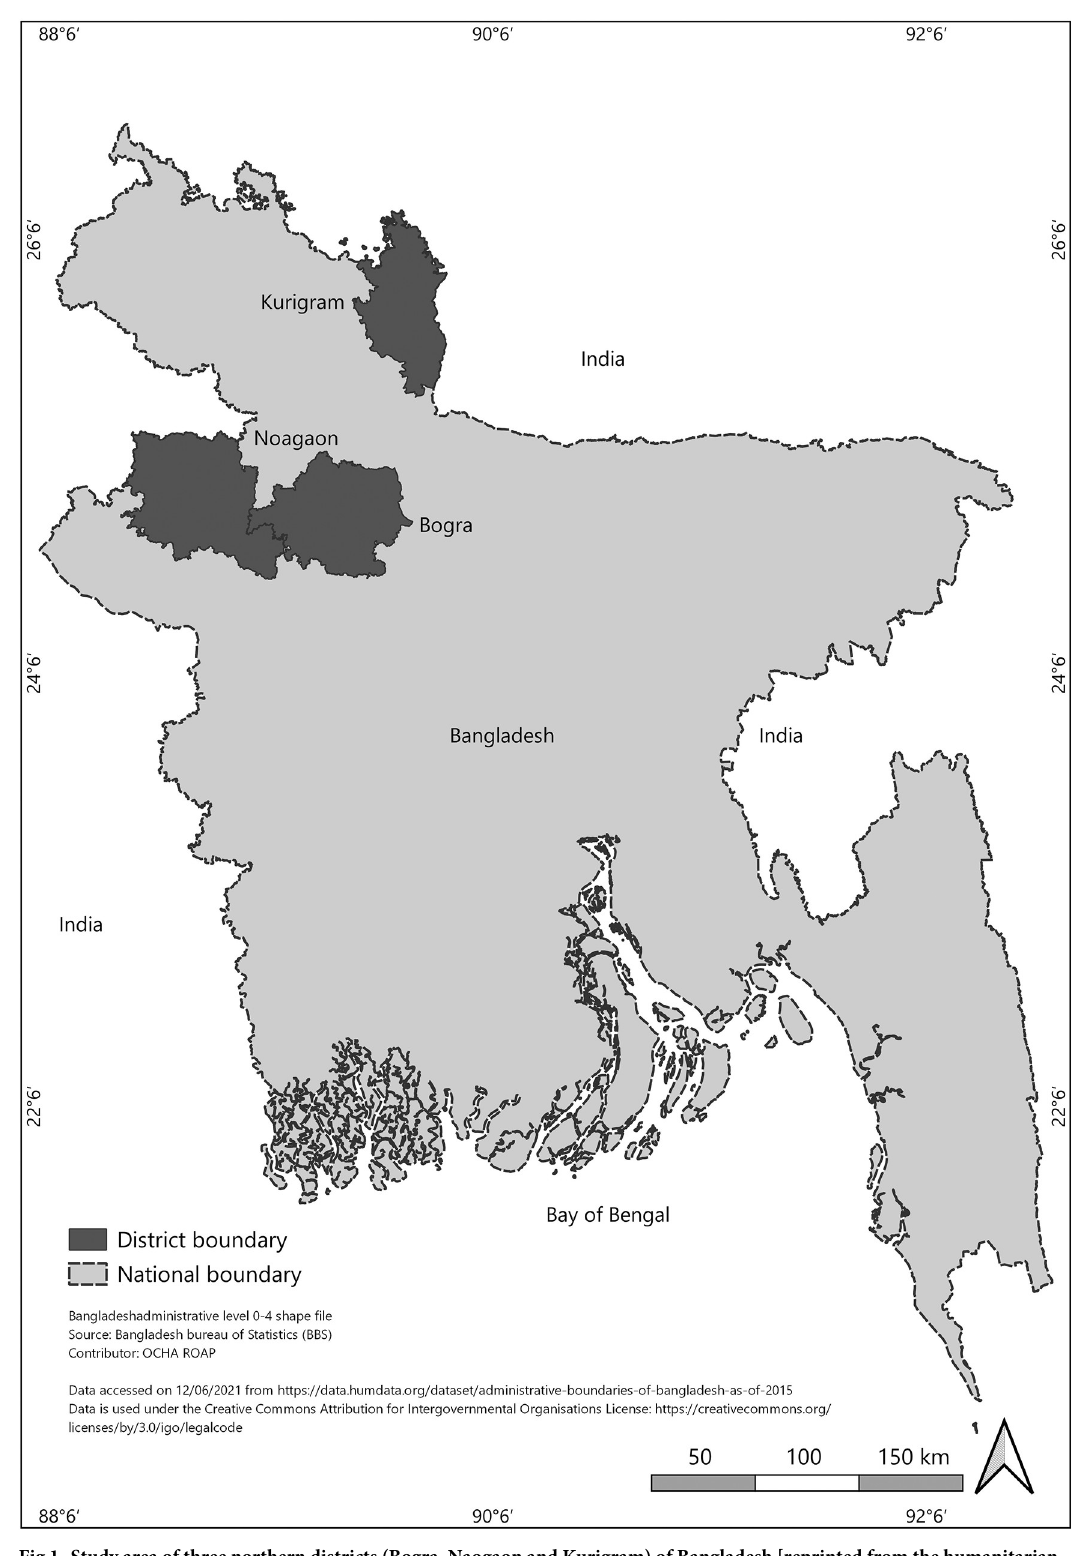
Fig 1. Study area of three northern districts (Bogra, Naogaon and Kurigram) of Bangladesh [reprinted from the humanitarian data exchange [63] under a creative common attribution 4.0 international license].